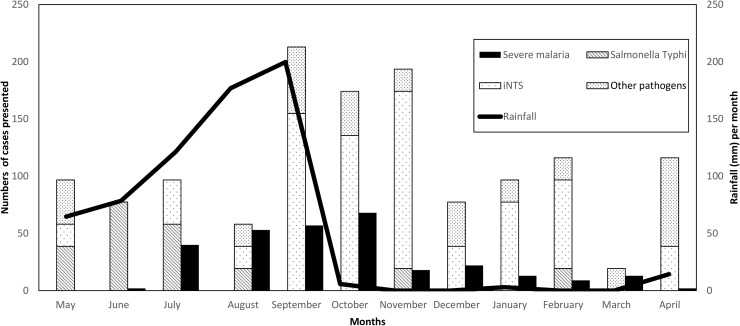
Distribution of monthly rainfall in relation to numbers of severe malaria and bloodstream infections for the patients from the HDSS zone.For comparison, the adjusted numbers of cases were used. HDSS: Health and Demographic Surveillance System. iNTS: invasive Non Typhoid Salmonellosis.